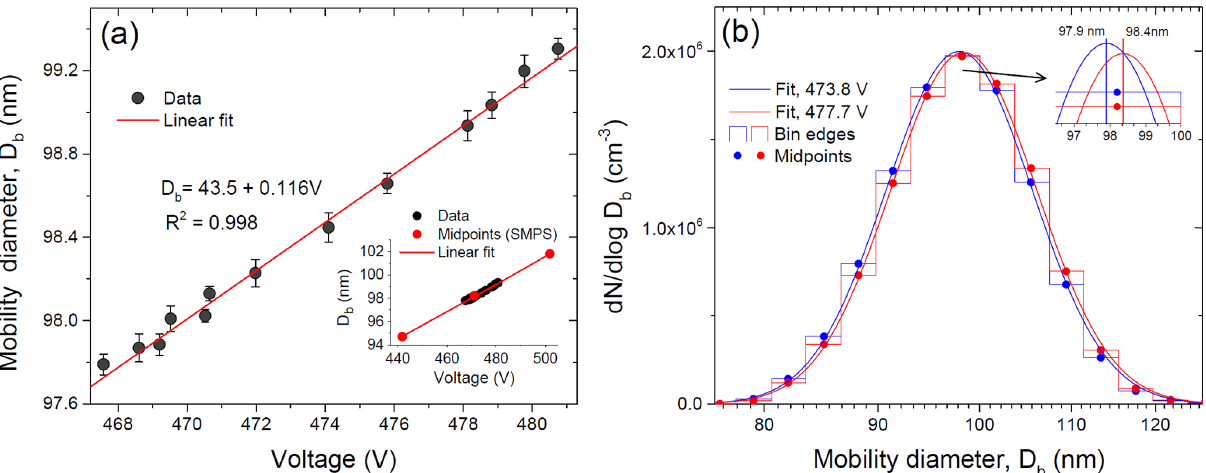
Figure 3. Modal mobility equivalent diameters obtained by the lognormal fit of the SMPS size distribution (DMA2) as a function of the voltage applied to the DMA1 center rod (a) and histogram, together with the fit curve received for two selected voltages (b) .